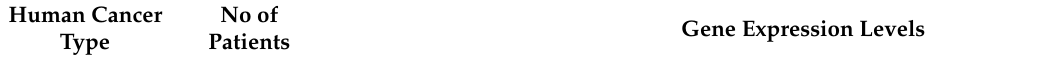
Table 1. IL-37 and SIGIRR mRNA expression levels (FPMKs) in various human cancer types. Data analyzed were obtained from www.proteinatlas.org [31] (accessed on 24 August 2022). p -Values compared to total lung or LUAD specimens using non-parametric Mann-Whitney U test are